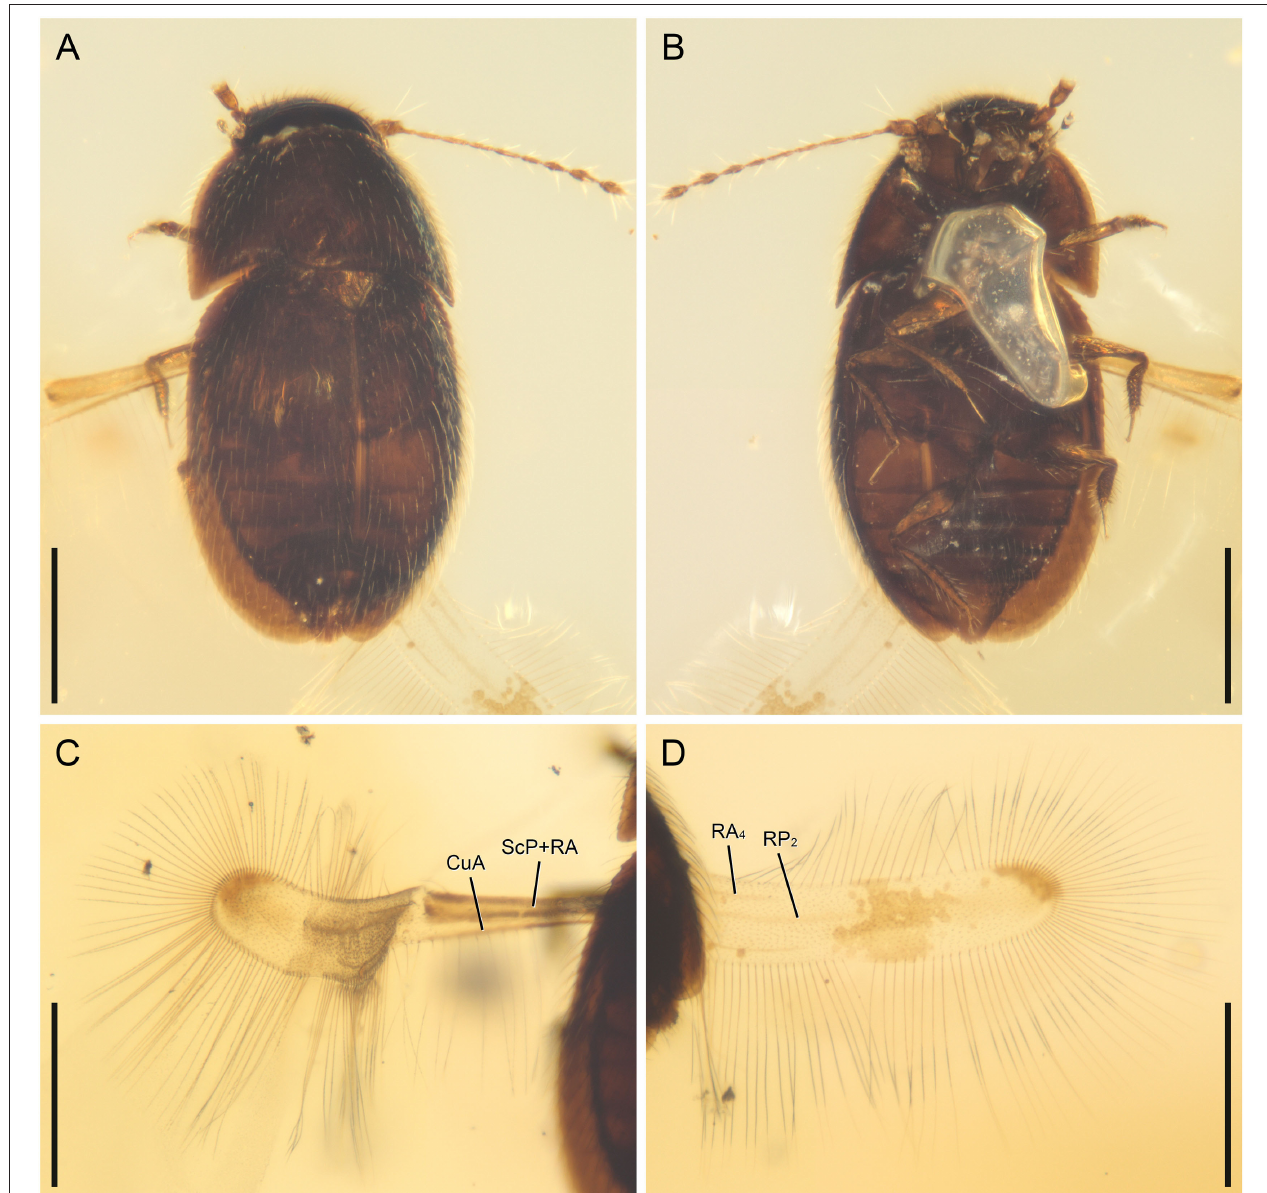
FIGURE 1 | Crenossidium slipinskii Li, Newton and Cai gen. et sp. nov. , holotype, NIGP180053, under incident or transmitted light. (A) Habitus, dorsal view. (B) Habitus, ventral view. (C) Left hind wing, dorsal view. (D) Right hind wing, dorsal view. Scale bars: 200 µ m.